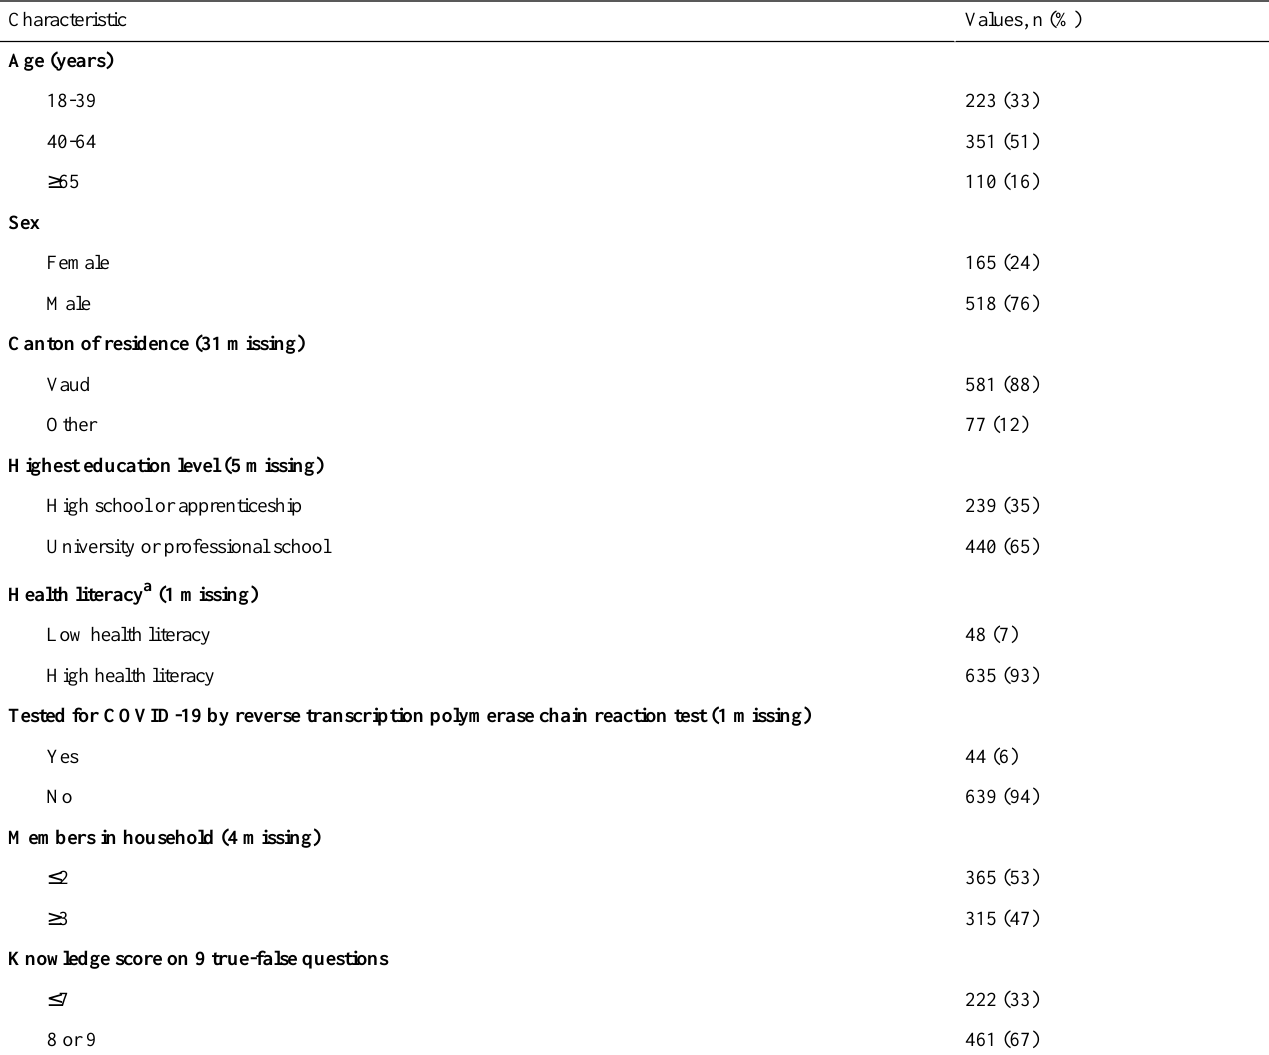
Table 2. Demographic characteristics of respondents who completed the questionnaire